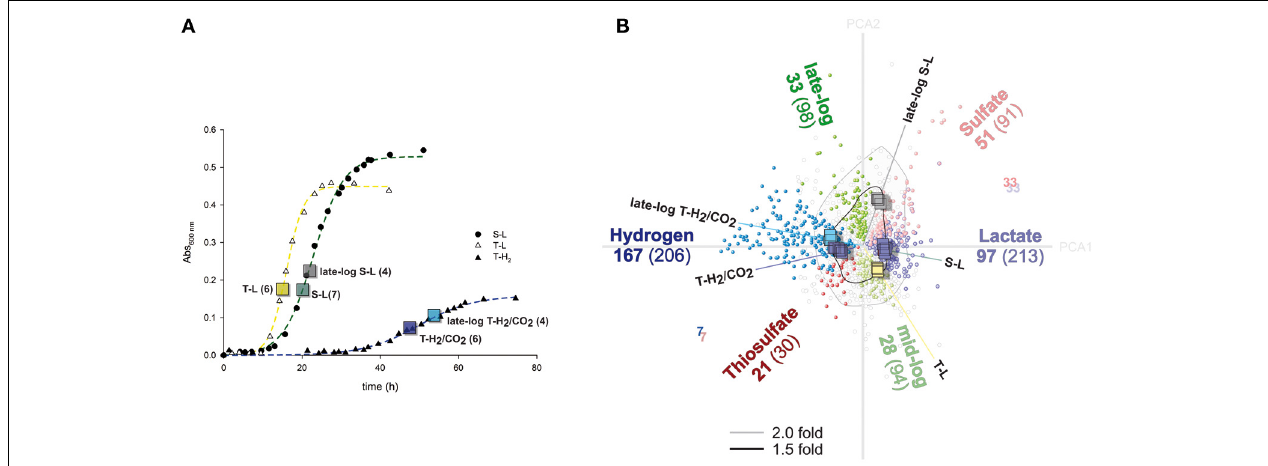
FIGURE 1 | Growth curves and illustration of differentially regulated genes. (A) Representative growth curves of cultures grown with lactate and sulfate (S-L), lactate and thiosulfate (T-L), hydrogen/CO 2 and thiosulfate (T-H 2 ). Boxes indicate absorbance values when sampling was performed. The numbers indicate amount of replicate microarray hybridizations for each growth condition. (B) Correspondence analysis (CA) provides an overview of variance and differentially regulated genes determined by ANOVA. Genes